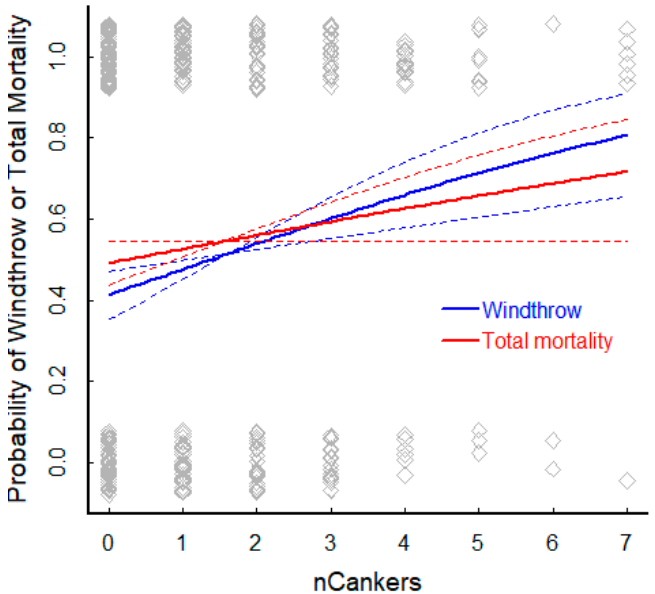
Figure 6. Relationship between the combined probability of windthrow and standing death of a tree and the number of cankers. All other variables are held at their mean values. Points are individual trees that either died (top of axis) or remained alive (bottom of axis). Dashed lines are 90% confidence intervals on the relationship.